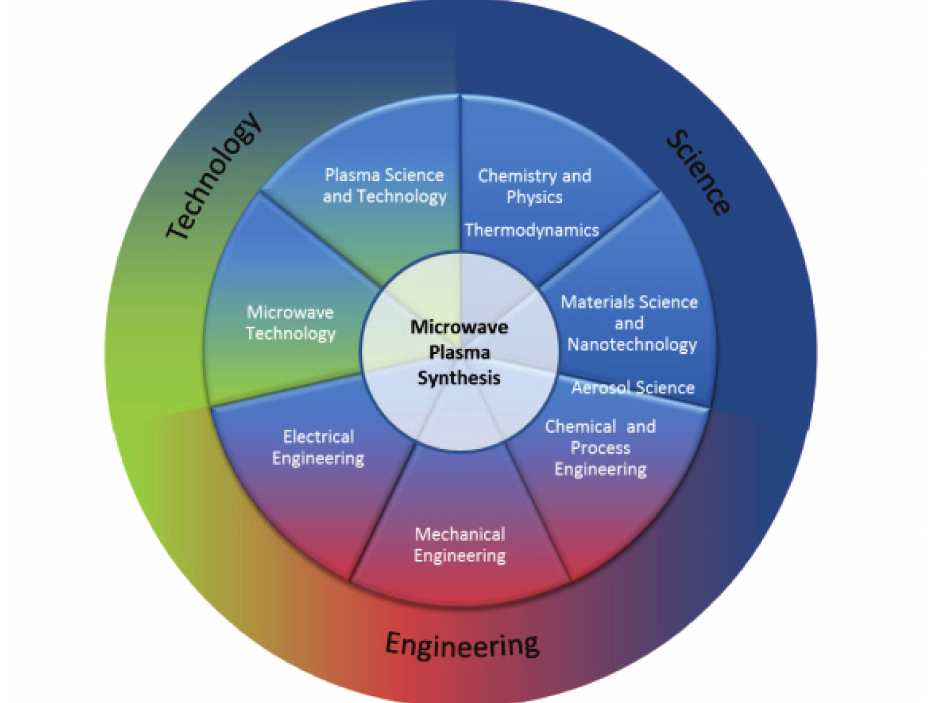
Figure 1. Interlinked research activities between microwave plasma synthesis and the contributing scientific, technological and engineering